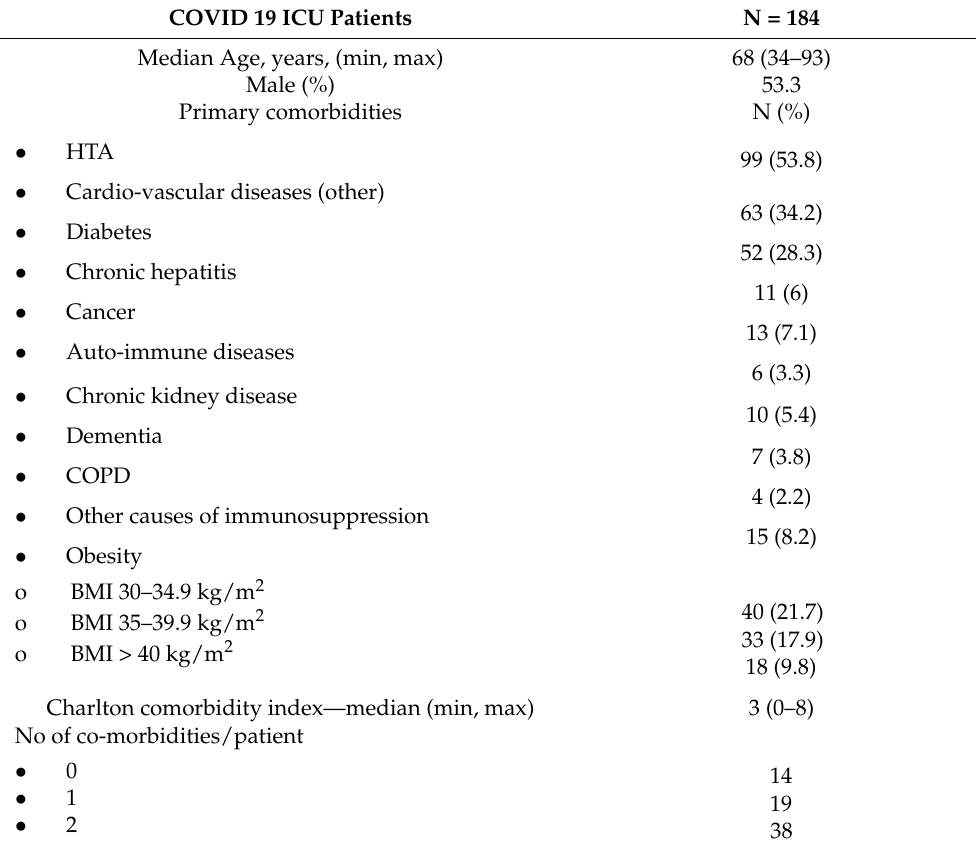
Table 1. Demographics and patient